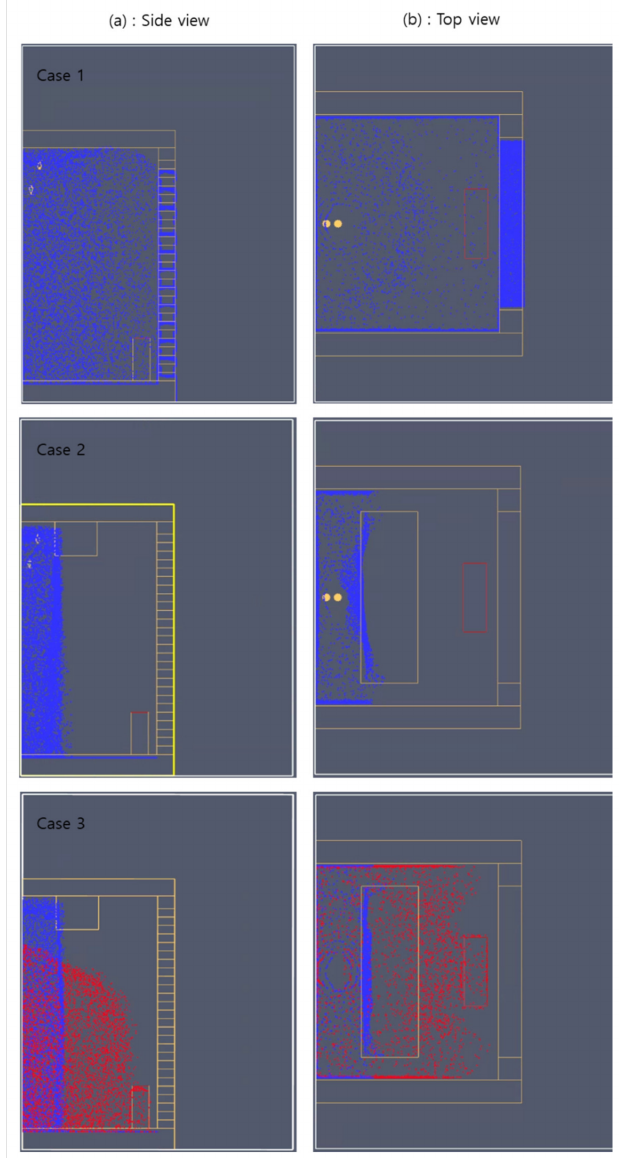
Figure 2. Sprinkler spray pattern according to the obstruction, ( a ): Side view, ( b ): Top